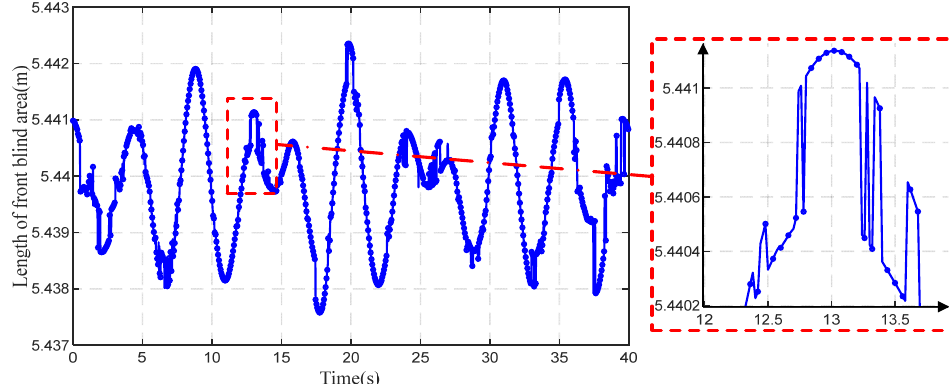
Figure 14. Online perception of front blind area during VVIV.